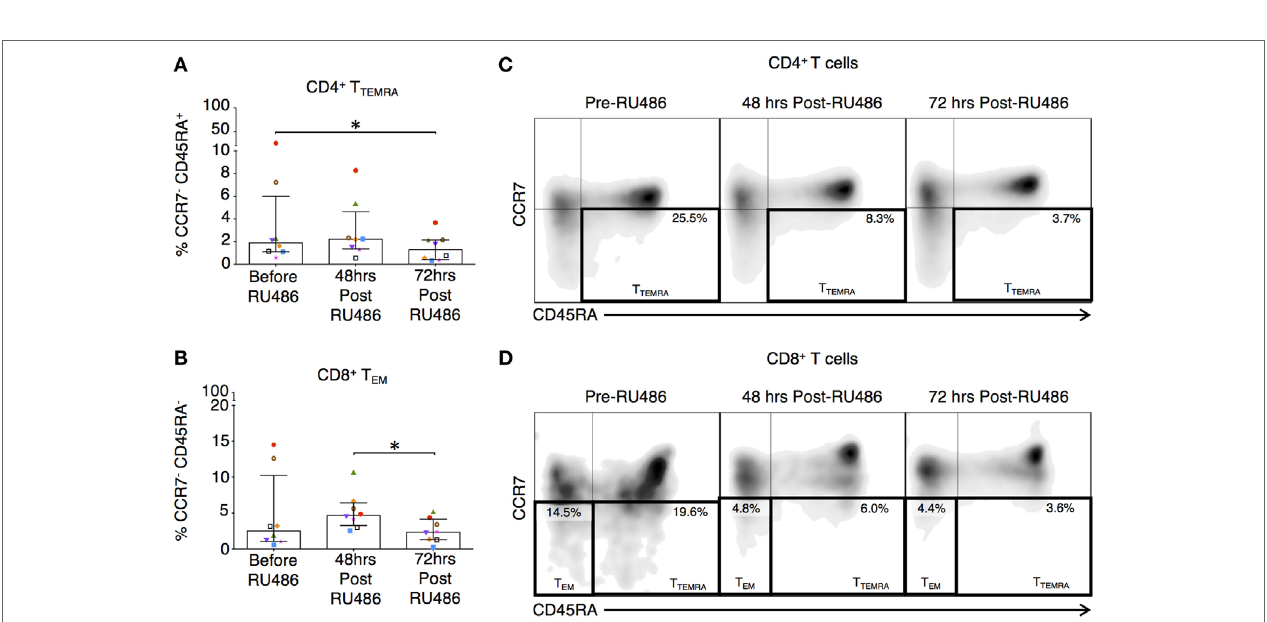
FigUre 9 | RU486 treatment is associated with reduced proportions of CD4 and CD8 differentiated effector memory subtypes. (a) Longitudinal analysis of proportions of CD4 + CCR7 − CD45RA − T EM and (B) CD8 T EM (CCR7 − CD45RA − ) in RU486-treated ( N = 8 ) symbols represent individual patients. P values are two tailed and significance is defined as * P < 0.05, by Freidman test with Dunn’s post hoc correction. Representative flow cytometry plots of (c) singlet CD4 + lymphocytes co-expressing CCR7 and CD45RA is shown with percentages of T EM cell, and (D) singlet CD8 + lymphocytes co-expressing CCR7 and CD45RA is shown with percentages of T EM and T TEMRA cells. Populations were gated using isotype controls.